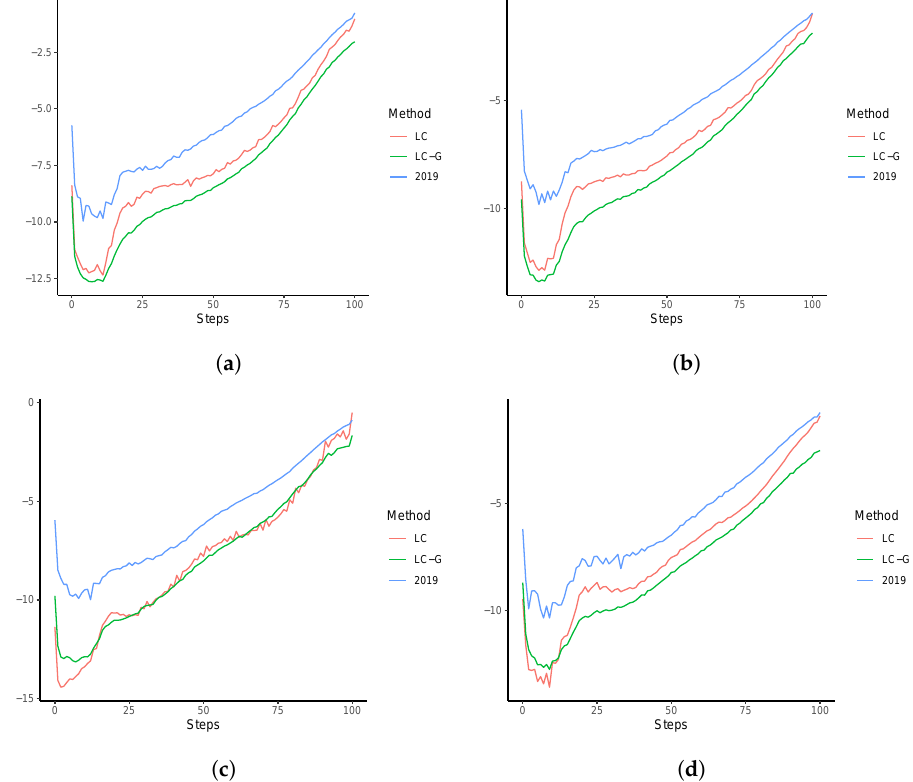
Figure 8. Forecast ln m x , t over 2020–2100: ( a ) Australia; ( b ) Canada; ( c ) Spain; ( d )